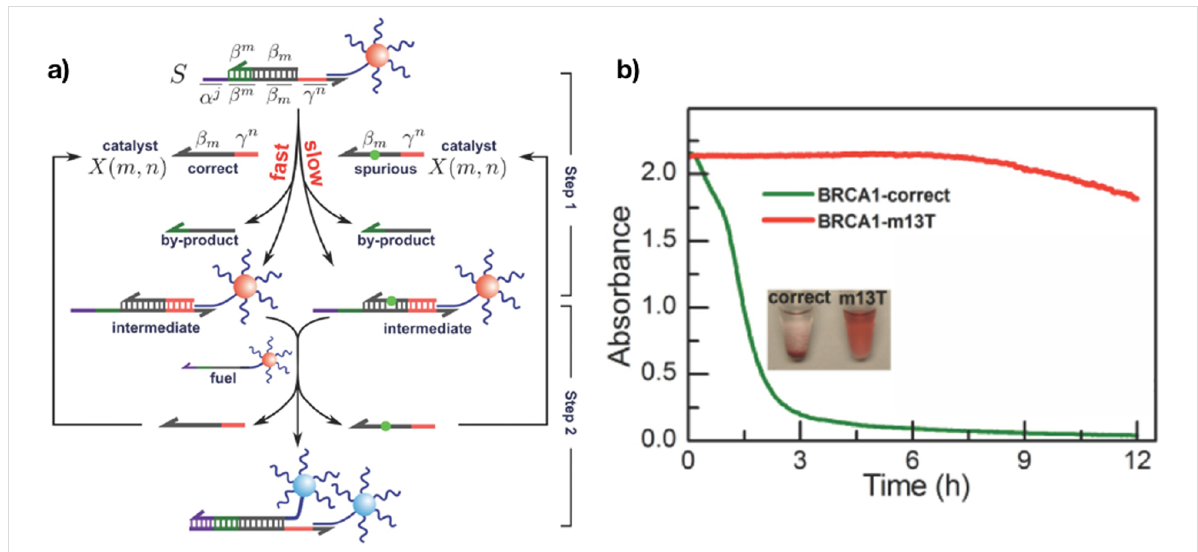
Figure 4: Discrimination of SNPs by means of the kinetics of particle aggregation. a) The spurious catalyst decelerates the toehold-exchange reac- tion and thus the formation of aggregates. (b) Time-dependent change of the color of the assay using spurious and correct targets. Reprinted with permission from [83], copyright 2014 John Wiley and